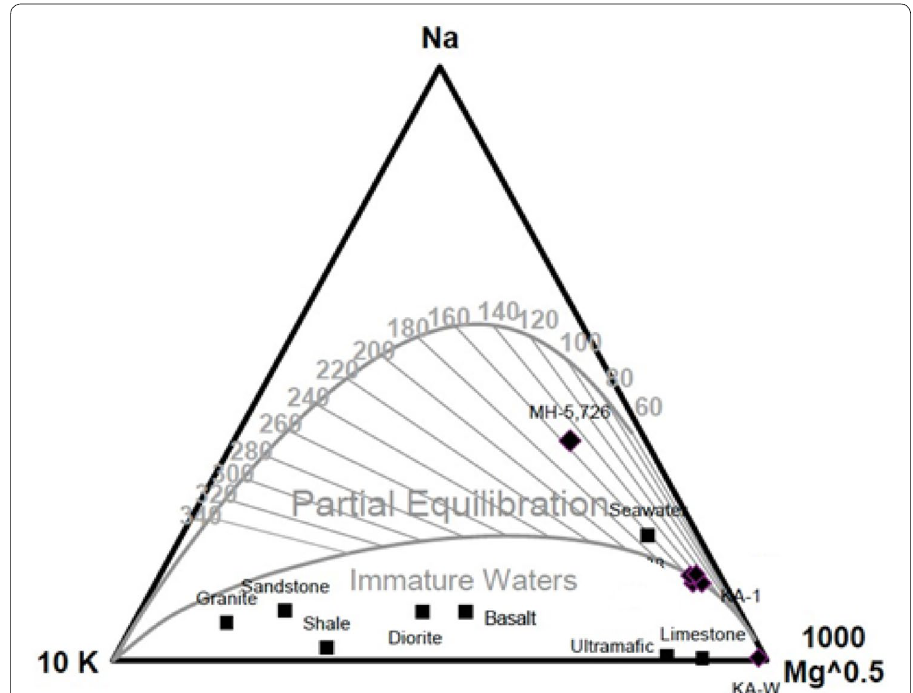
Fig. 3 KA-1 and KA-W samples plotted on Giggenbach (1988) triangular